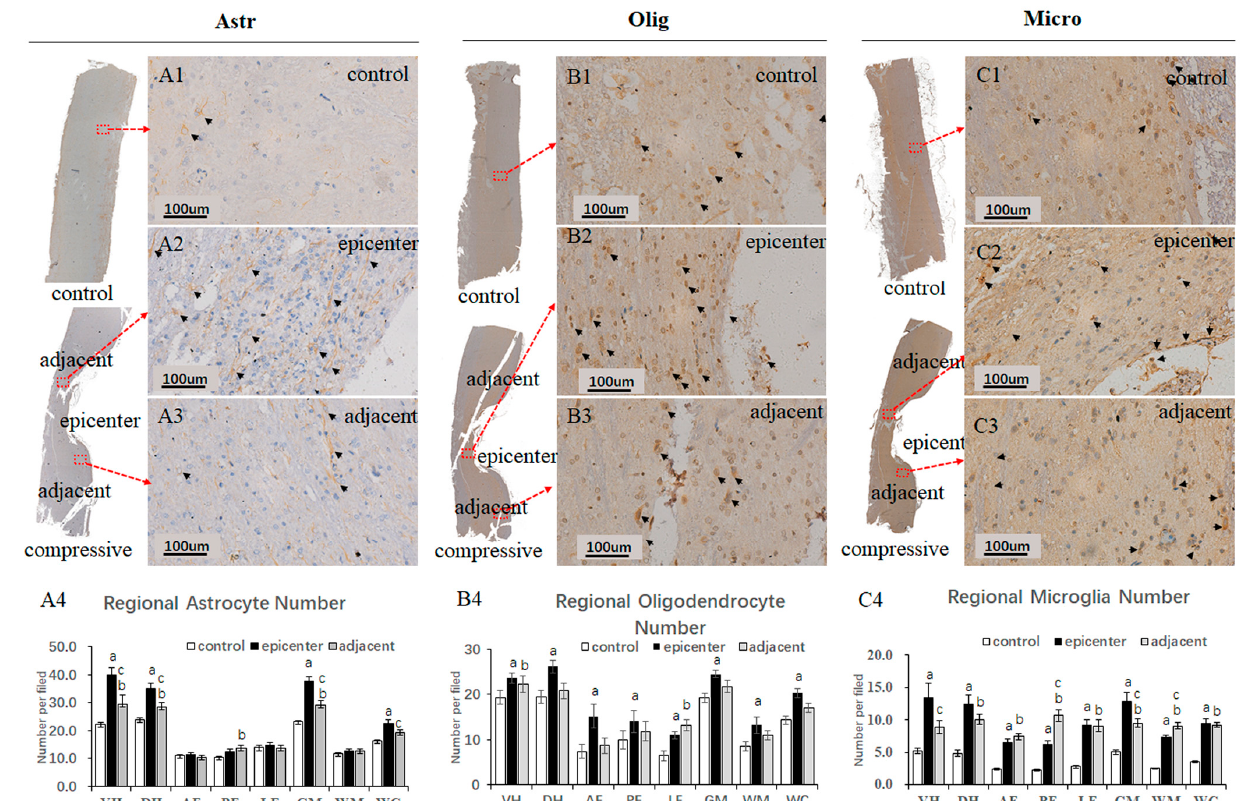
Figure 9. Neuroglial cells activation after chronic compression. Anti-GFAP, Anti-OLIG2 and Anti- AIF1/Iba1 antibody labeled astrocytes ( A1 – A3 ), oligodendrocytes ( B1 – B3 ) and microglial cells ( C1 – C3 ) in the control group, compressive epicenter and adjacent level, respectively. A large number of reactive astrocytes ( A2 , black arrowhead), oligodendrocytes ( B2 ) and activated microglial cells ( C2 ) were seen in the compressive epicenter. Milder increased activation of astrocytes ( A3 ), oligodendrocytes ( B3 ) and activated microglial cells ( C3 ) were also seen in the adjacent level. Regional quantitative analysis of results demonstrated an increased number of astrocytes ( A4 ),